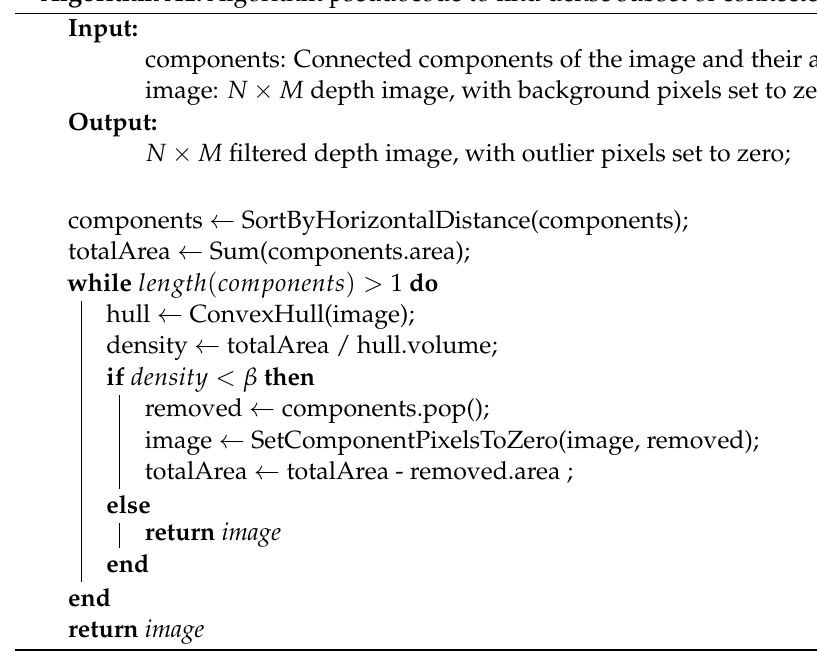
Algorithm A1: Algorithm pseudocode to find dense subset of connected